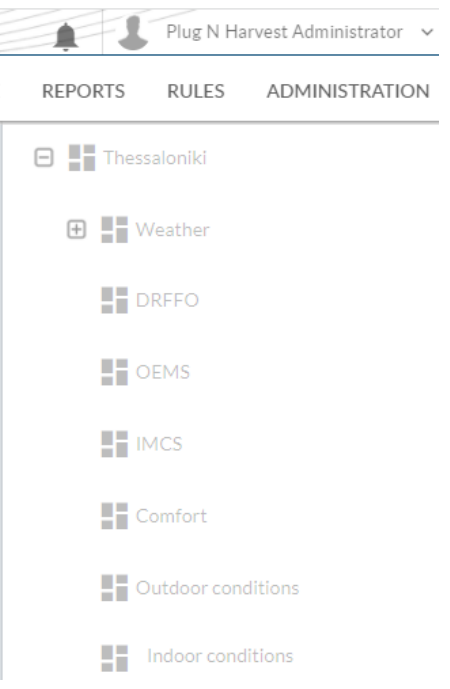
Figure 5. Dashboard menu from available P-n-H